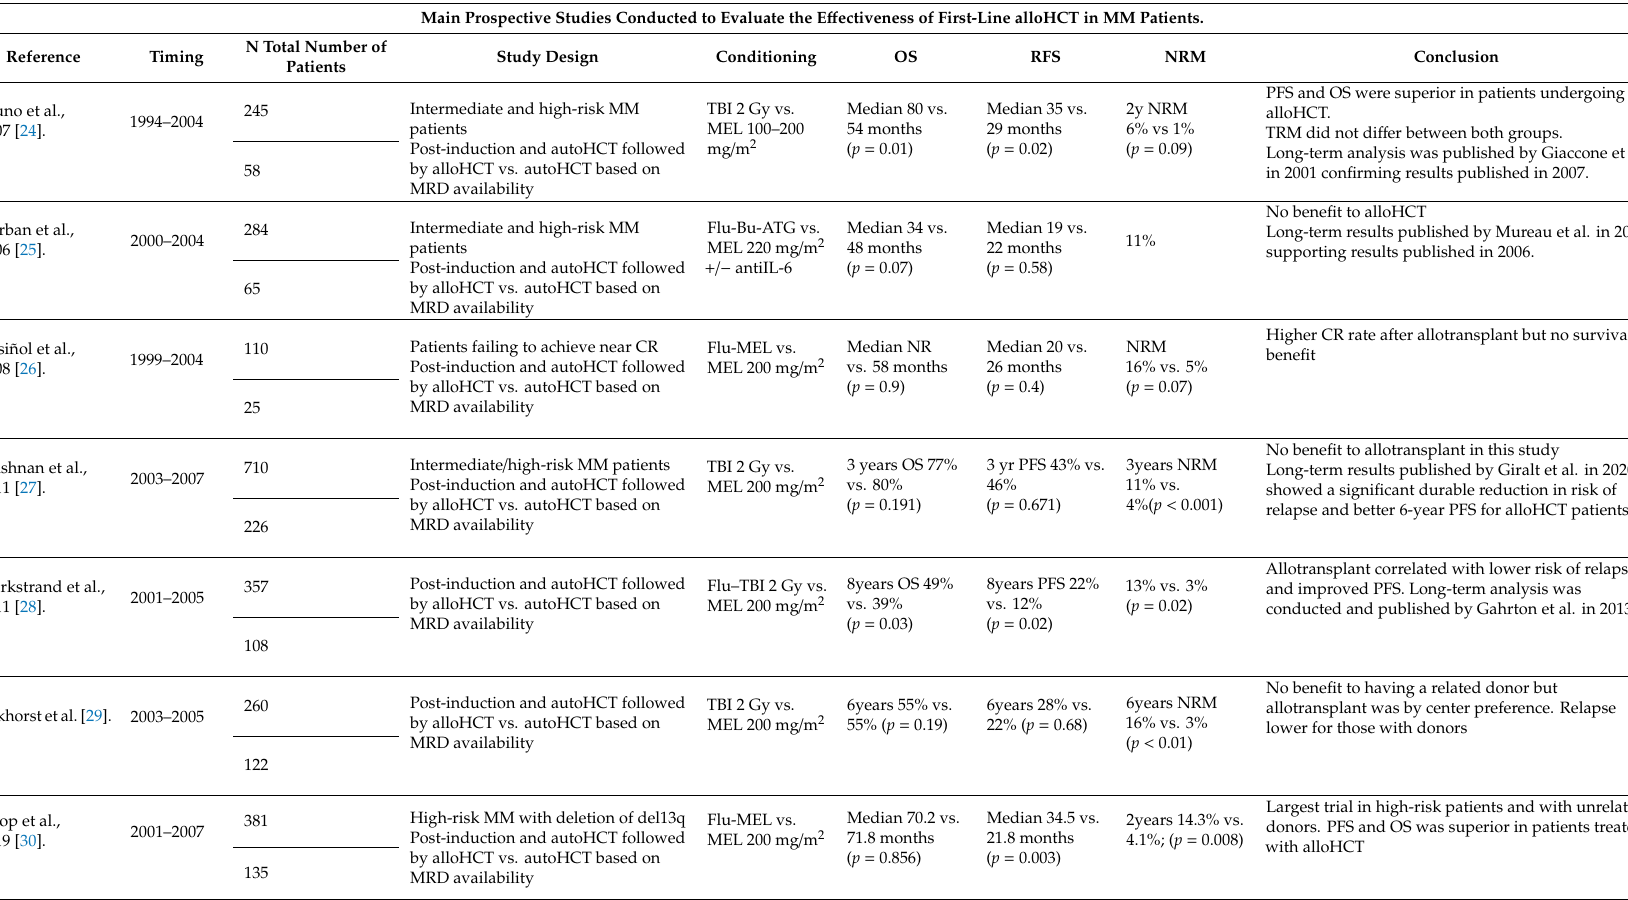
Table 1. Main prospective studies conducted to evaluate the e ff ectiveness of first-line allogeneic hematopoietic cell transplantation in multiple myeloma